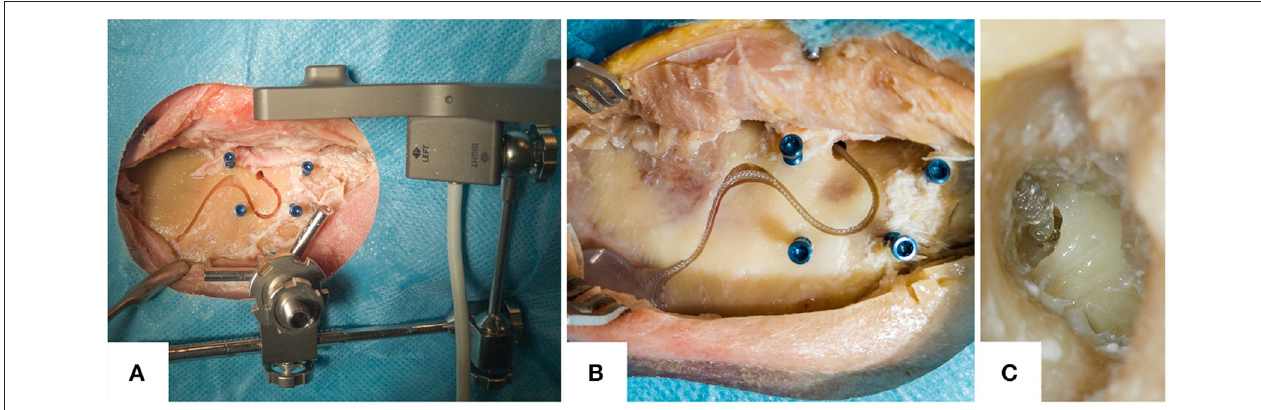
FIGURE 8 | Example photos of the resulting electrode lead management. (A) The resulting electrode channel with the attached patient marker on the tripod attachment. (B) Close-up of the electrode lead embedded within the resulting channel, in another specimen. (C) A microscope image through the external auditory canal after the elevation of the tympanomeatal flap. It shows the tapered neck of the electrode array, which is being inserted into the cochlea at the round